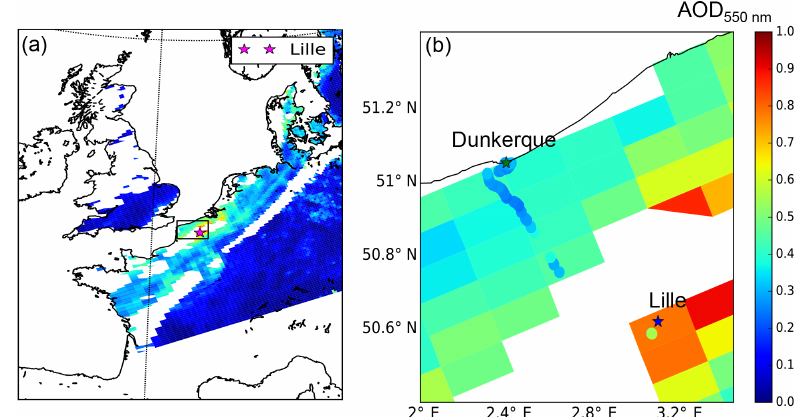
Figure 5. Spatial distribution of (a) MODIS Aqua AOD (550nm) daily product MYD04 10km; (b) AOD (550nm) from PLASMA sun photometer on-road measurements along the Lille–Dunkerque transect on 26 August 2016 are overlapped on MYD04 AOD